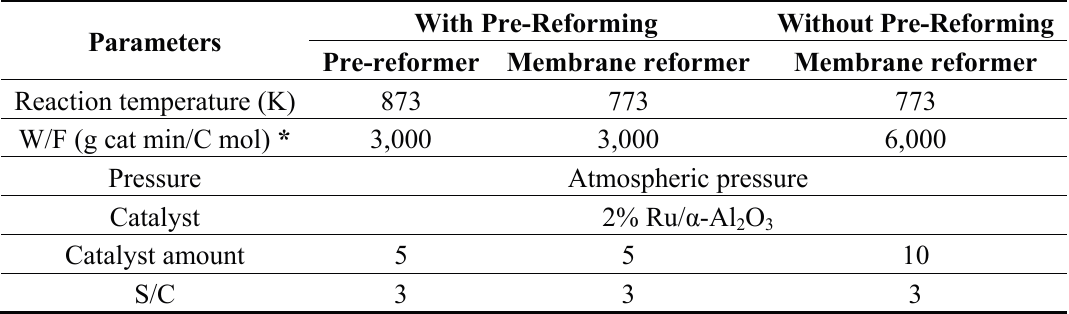
Table 4. Variation of key parameters (reaction temperature, W/F, pressure, catalyst, catalyst amount and S/C) with and without prereforming